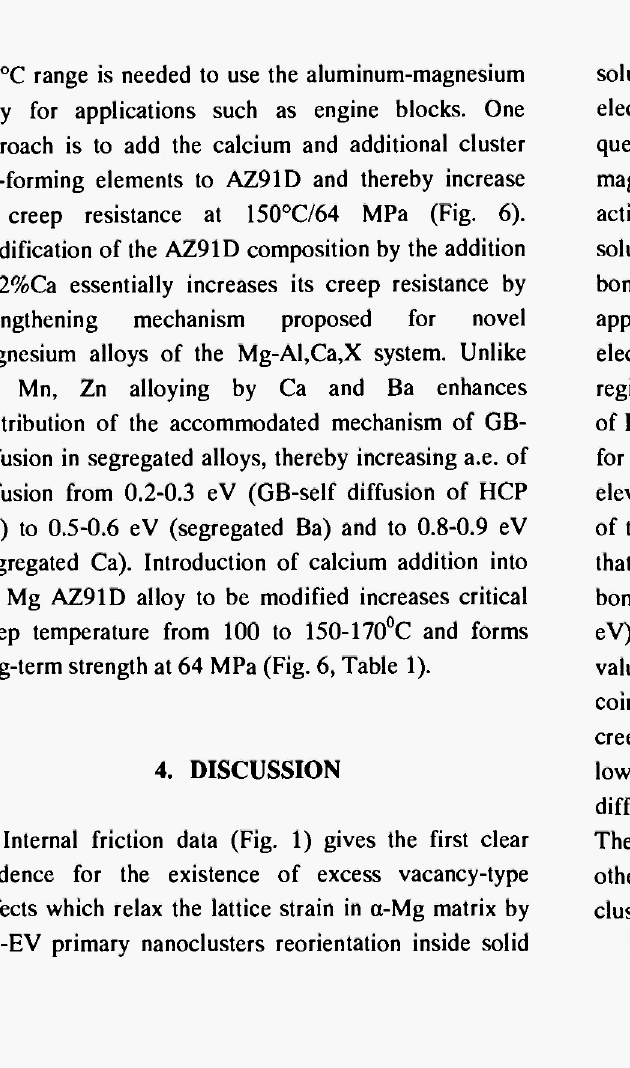
Fig.7: Steady state creep rate - stress dependencies for AZ91D alloy by using stress - change experiments at different temperatures: 1- 150 °C; 2- 160 °C; 3 - 175 °C; 4 - 200